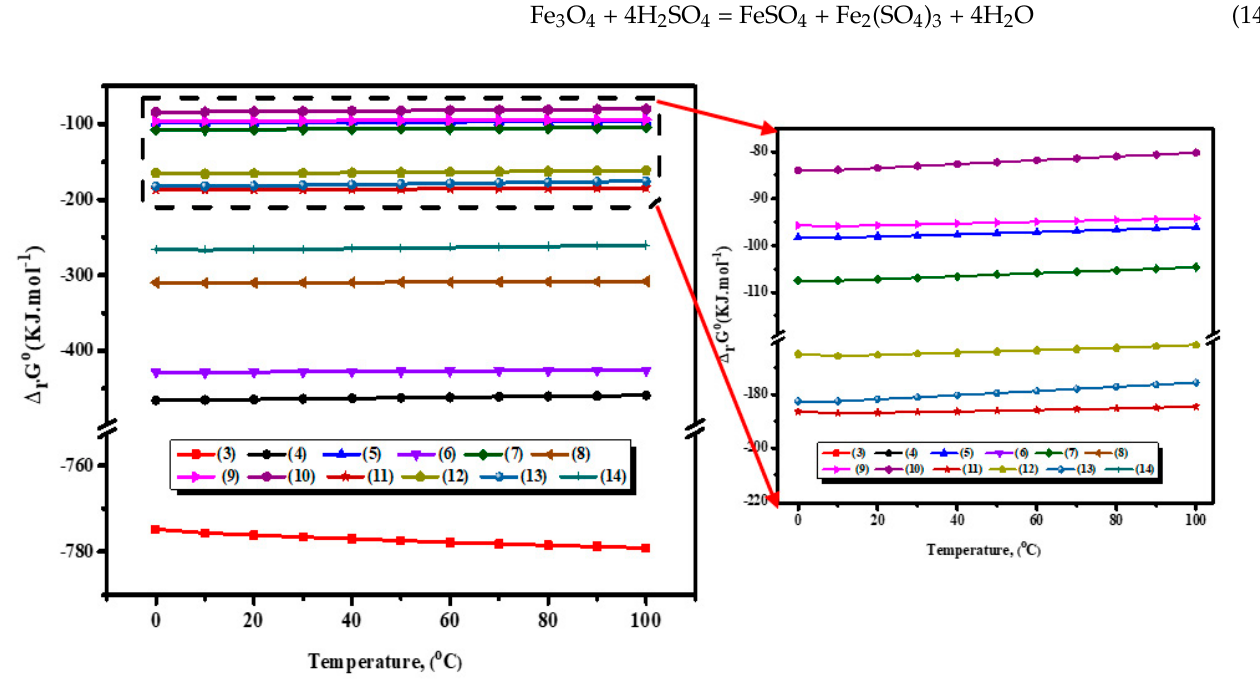
Figure 3. Relationship between Δ rG 0 -T for main reactions in H 2 SO 4 leaching process of WLSR.